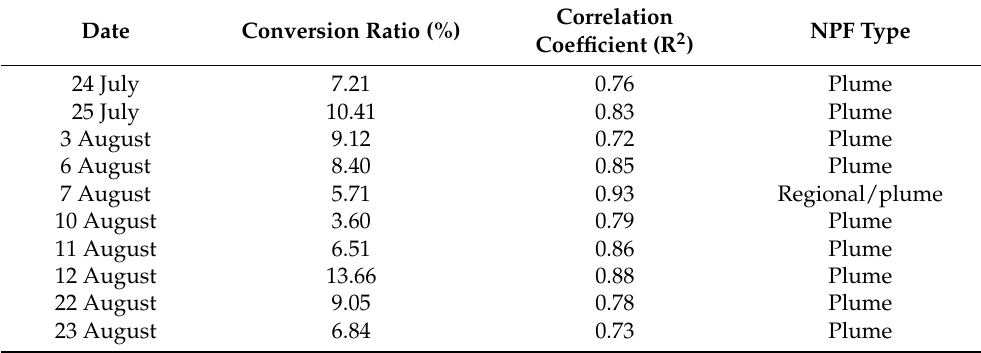
Table 2. The apparent conversion ratios and the correlation coefficients for all the events of the study, along with the types of